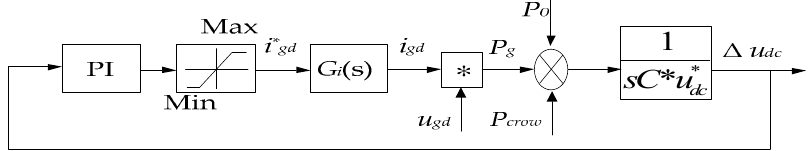
Figure 3. Control block diagram of inverter of the external d -axis voltage loop.